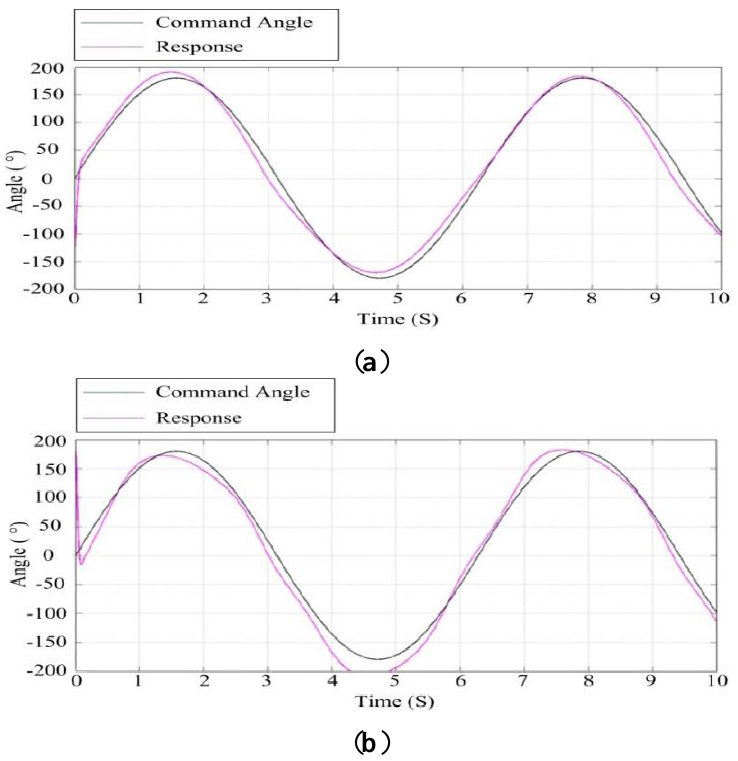
Figure 18. Response curves of the ISP at the speed of 14 m/s: ( a ) the azimuth gimbal; ( b ) the pitch